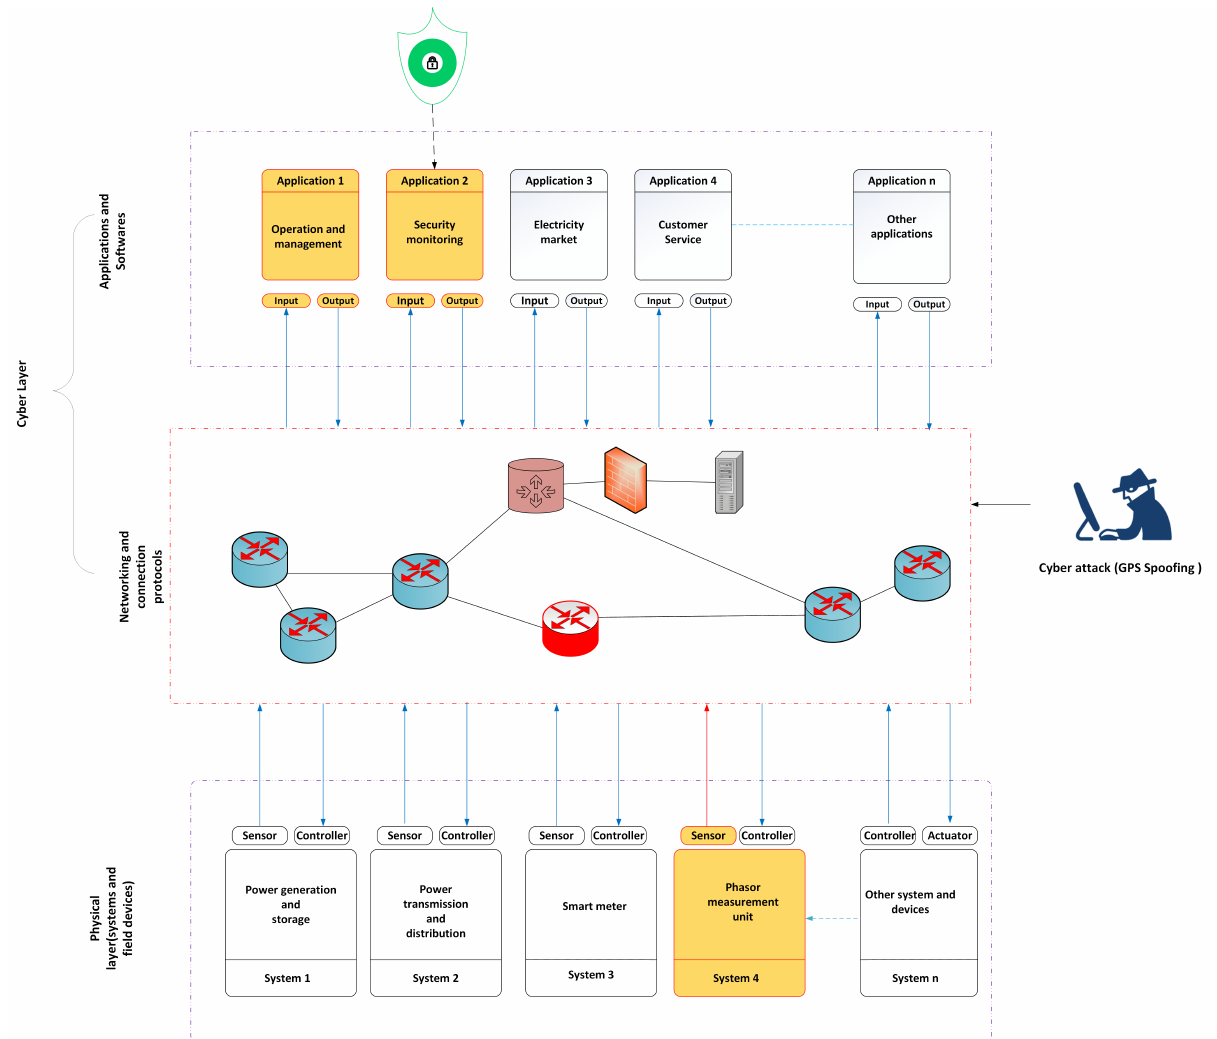
Figure 5. General illustration of GPS spoofing attack in smart